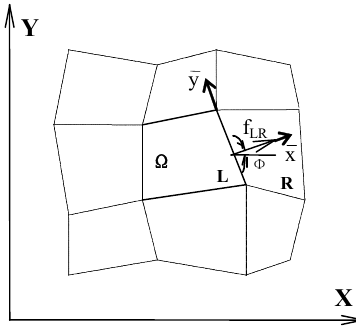
Figure 6. The finite volume Ω . x is left side of boundary, y is right side of the boundary, f LR is flux, Φ is Figure 6. The finite volume Ω . x̄ is left side of boundary, ȳ is right side of the boundary, f (cid:2896)(cid:2902) is flux, the angle in the normal direction of the Φ is the angle in the normal direction of the boundary.